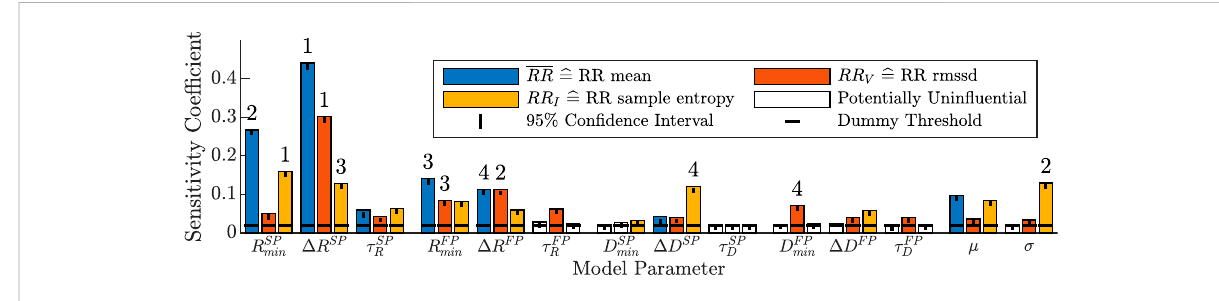
FIGURE 5 Distribution-based sensitivity indices describing the in fl uence of changes in the 14 model parameters to changes in the three RR series characteristics.Amodelparameter isassumedtohavein fl uenceontheRRseriescharacteristicsifthesensitivitycoef fi cientisabovethethresholdof the dummy parameter (horizontal black line), otherwise it is not in fl uential and illustrated with a white bar. The black vertical line illustrates the 95% con fi dence interval of the t bootstrapping iterations of the sensitivity coef fi cient. The ranking of the four most in fl uential model parameters for each RR series characteristic is shown with the numbers above the bars.